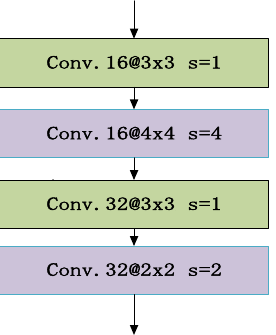
Figure 6. The mixed progressive convolution layers. The mixed progressive convolution layers are composed of a stride of 4 and size of 4 × 4 convolution kernel and a stride of 2 and size of 2 × 2 convolution kernel together with stride of 1 and size of 3 × 3 convolution kernels. The design of mixed progressive convo- lution layers in FCNN can save training time and the combination of convolution kernels with different sizes can increase the diversity of feature extraction.